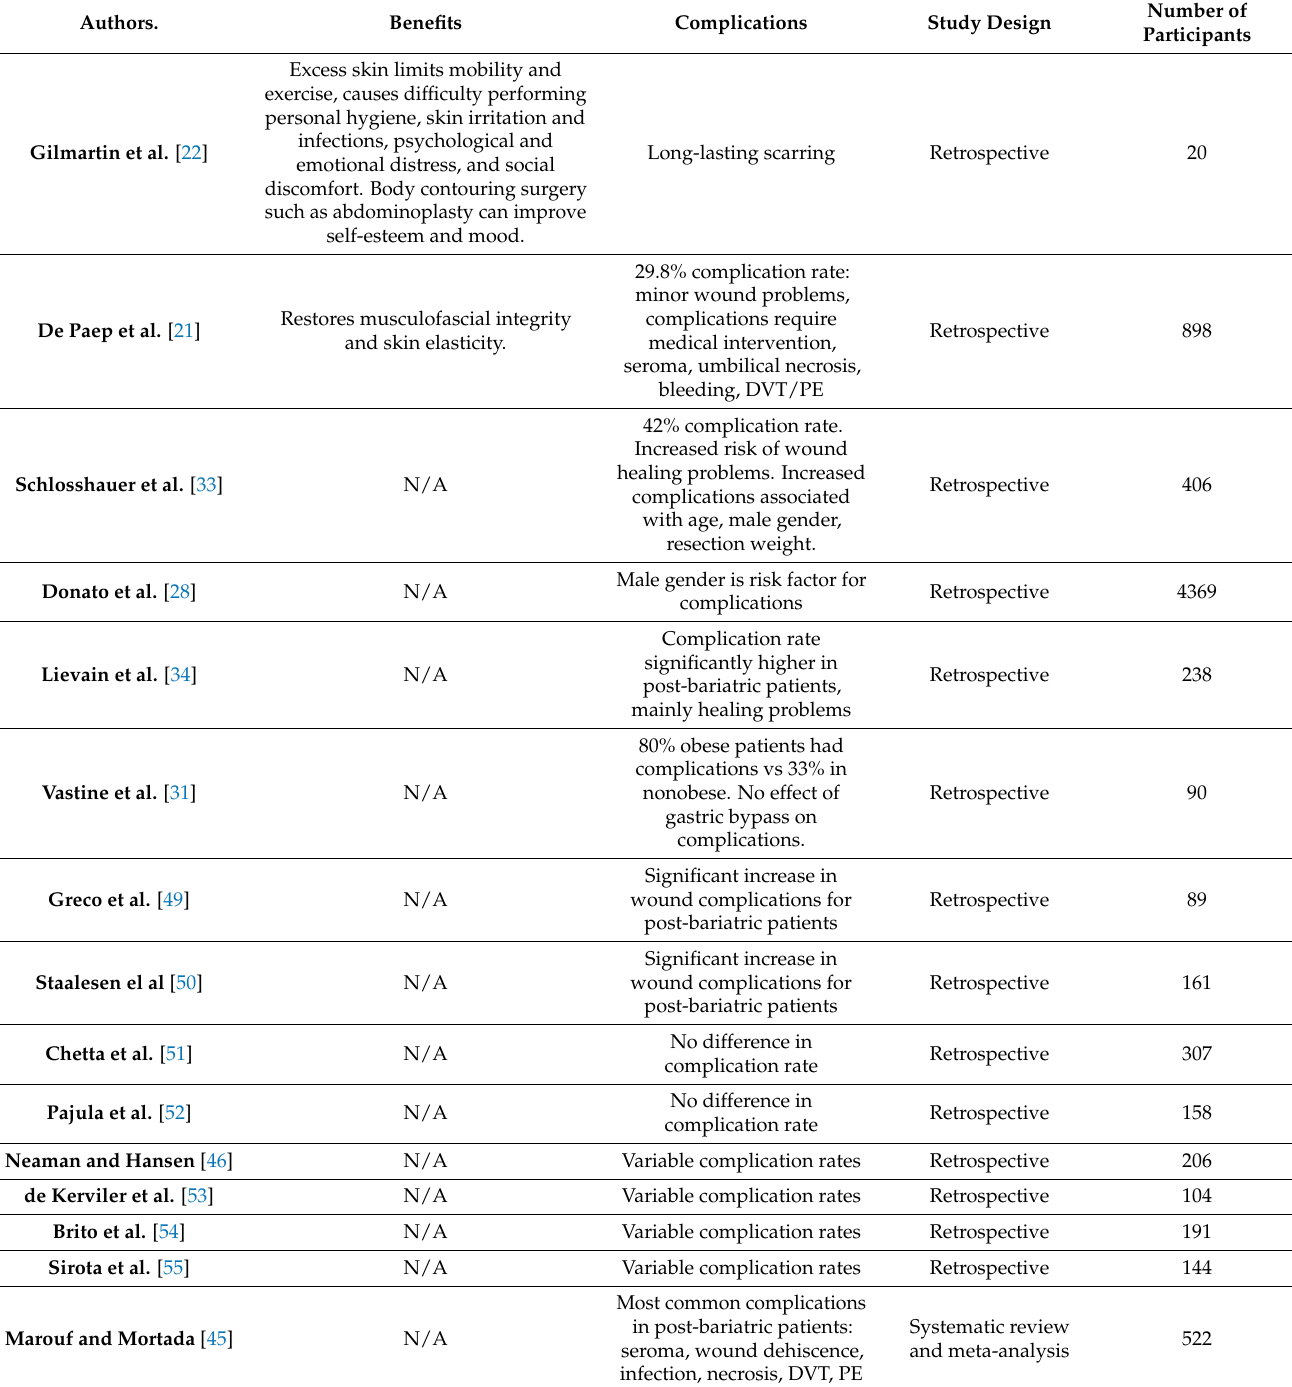
Table 1. Different abdominoplasty techniques’ benefits and